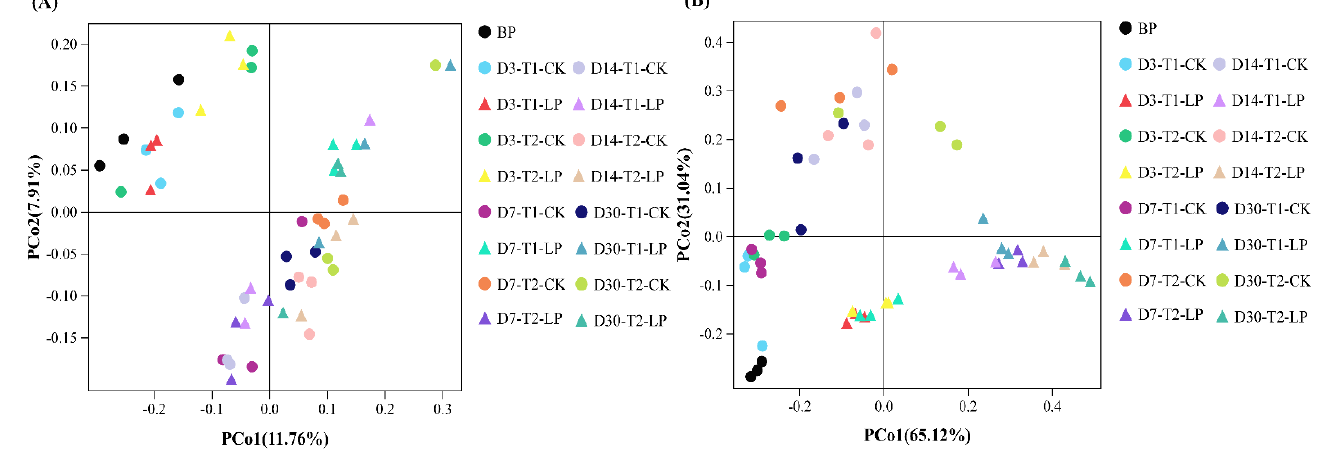
Figure 1. Principal Coordinates Analysis (PCoA) of bacterial communities for B. papyrifera leaves silage (days 3, 7, 14, 30) treated with LP inoculant and stored at 15 °C (T1) and at 30 °C (T2). Algorithm based on unweighted Unifrac metric ( A ) and weighted Unifrac metric ( B ). BPL, B. papyrifera leaves; CK, the control; LP, Lactobacillus plantarum; D3, D7, D14, D30, after 3, 7, 14, 30 days ensiling, respectively.